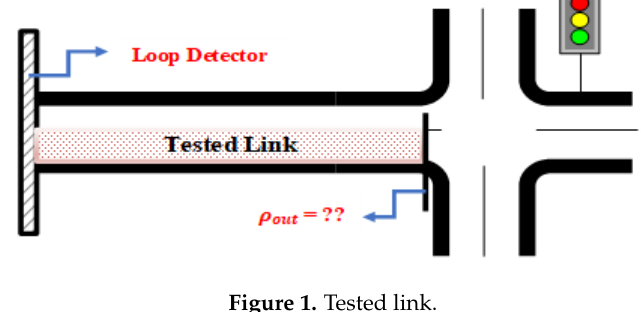
Figure 1. Tested